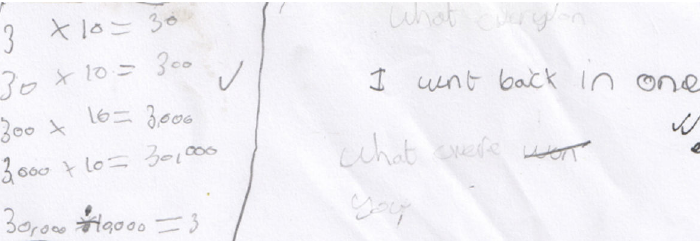
Figure 5. A student extends to division by 10,000: “I went back in